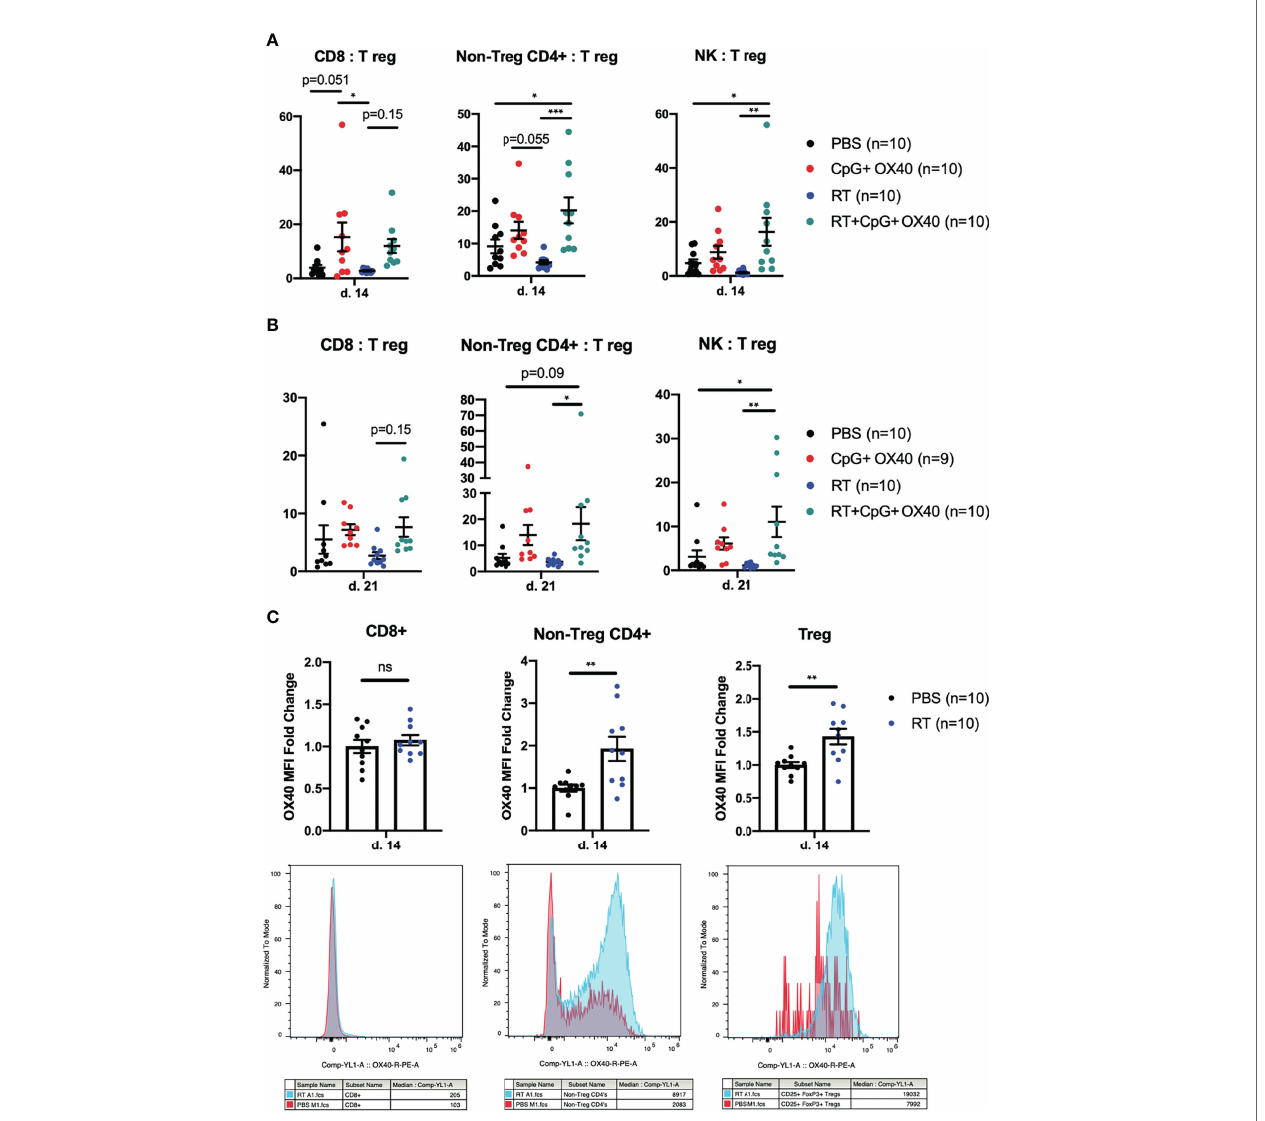
FIGURE 5 | Phenotypic Changes in TIL Following In Situ Vaccination. (A, B) The combined results from two independent experiments (n=4-5 per group, per experiment) showing the ratios of CD8:Treg, CD4+ non-Treg : Treg, and NK : Treg within the B78 TME (A) 14 days and (B) 21 days after treatment with PBS (black), CpG+OX40 (red), RT (blue), and RT+CpG+OX40 (teal). (C) The combined results from two independent experiments (n=5 per group, per experiment) showing the fold-change in OX40 MFI expression on CD8+, CD4+ non-Treg cells, and Tregs within B78 tumors 14 days after treatment with PBS (black) or RT (blue). Representative histograms for each T cell subpopulation provided below fold-change fi gures. Average OX40 MFI values in the PBS cohort were calculated for each separate experiment, then used to determine fold change differences for each sample from that particular experiment. Each symbol represents the TIL from one mouse. Flow gating strategy is presented in Supplementary Figure 4 . P values for effector/Treg ratios were calculated using one-way ANOVA with Tukey ’ s multiple comparison tests. P values for OX40 expression were calculated using a Mann-Whitney test. *P ≤ 0.05; **P ≤ 0.01; ***P ≤ 0.001; NS, nonsigni fi